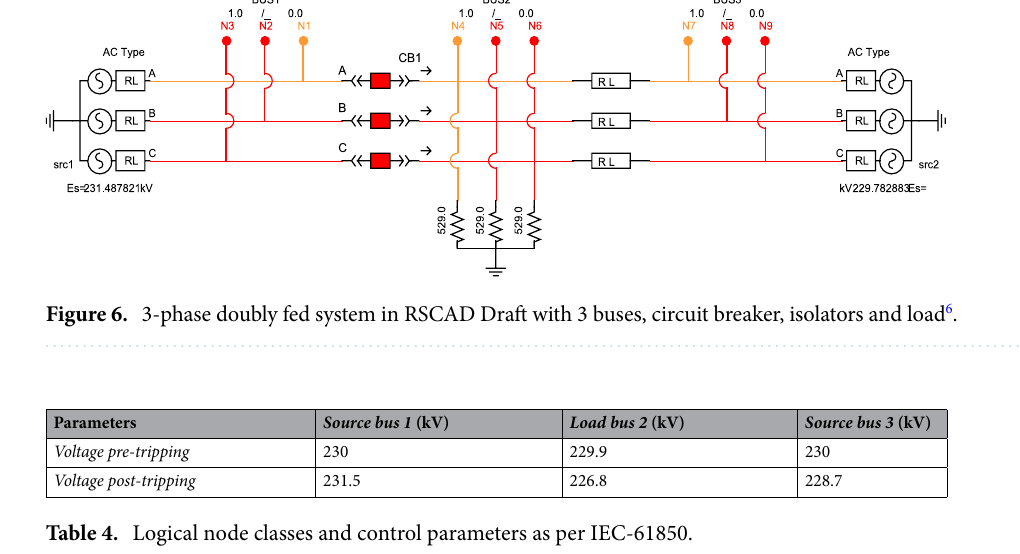
Table 4. Logical node classes and control parameters as per